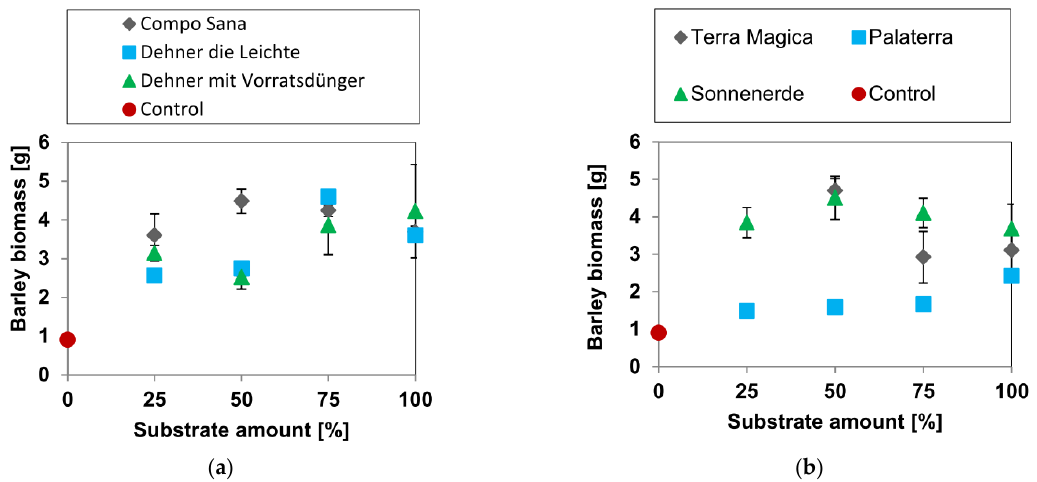
Figure 1. Barley yield per pot after 30 days in peat-based ( a ) and biochar-based ( b ) growing media mixed with sand in different amounts. In this Figure, 0% = control (pure sand) and 100% = pure growing media. Error bars represent standard error of the mean (n = 5).